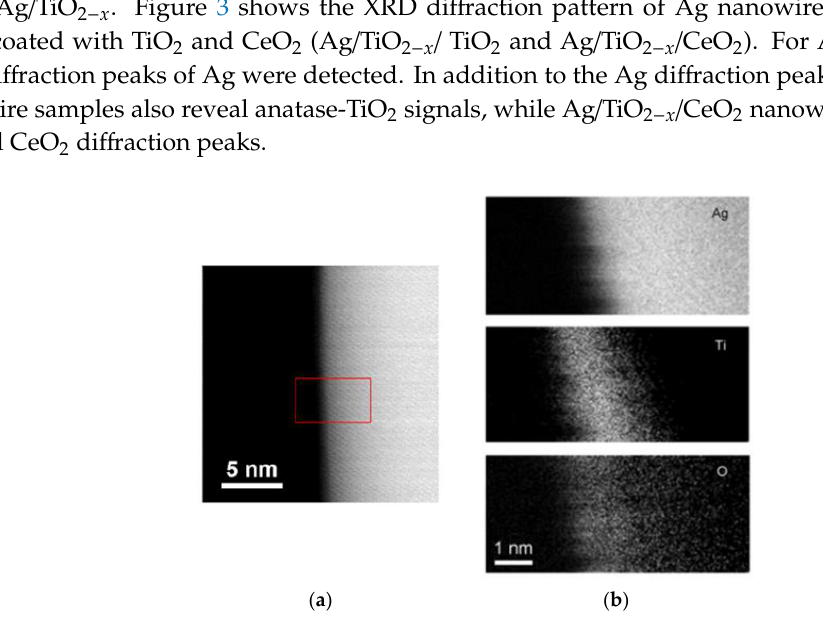
Figure 2. ( a ) high-angle annular dark-field (HAADF)-STEM image and ( b ) EELS mapping of Ag NW edge grown onto the TiO 2 substrate after heating at 300 ◦ C for 3 h. The elemental mapping was slightly shifted due to specimen